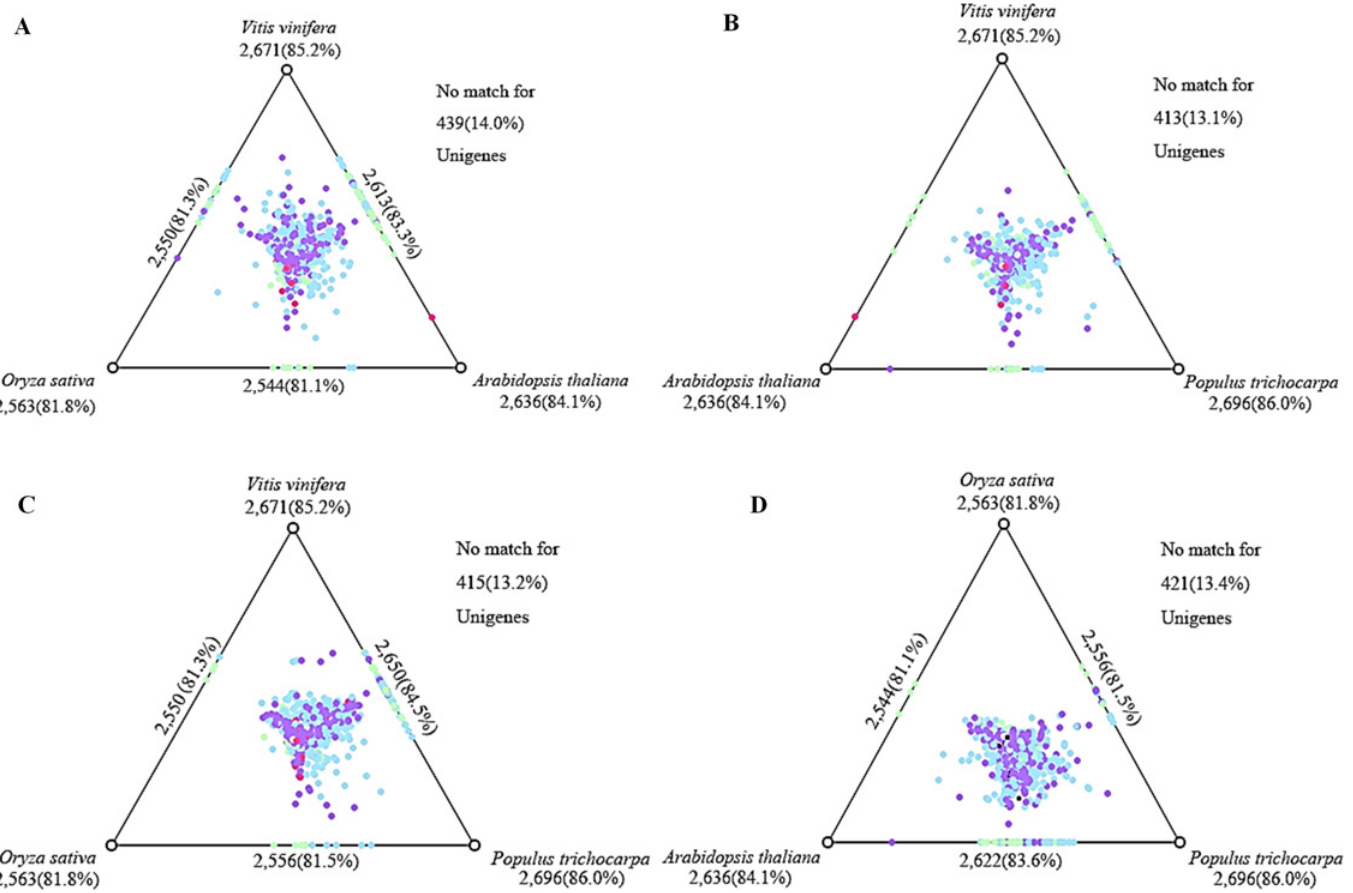
Fig 3. SimiTri profile of the unigenes. The 3,135 uniESTs were blastx searched against the protein sequences of four different species (A, B, C, D) (E- value (cid:3) 10 − 5 ). The color was coded based on the highest BLAST score as follows: red > 750; pink > 450; purple > 250; blue > 100, and green <